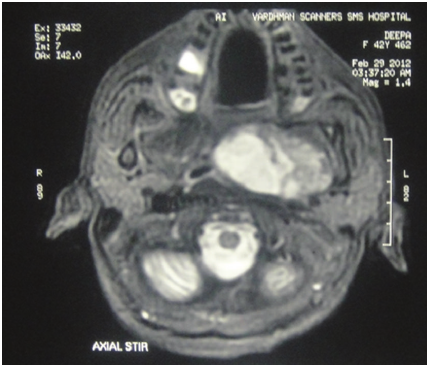
Figure 1: T1-weighted post-Gd MRI large showing heterogenous mass in left parapharyngeal space.